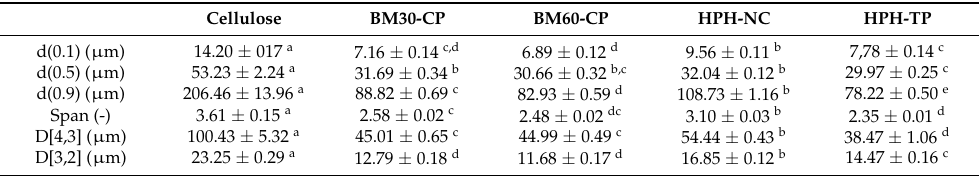
Table 1. Effect of different mechanical treatments of cellulose and tomato pomace dispersed in water on particle size distribution (expressed as span and characteristic diameters) in comparison with pure water and untreated cellulose